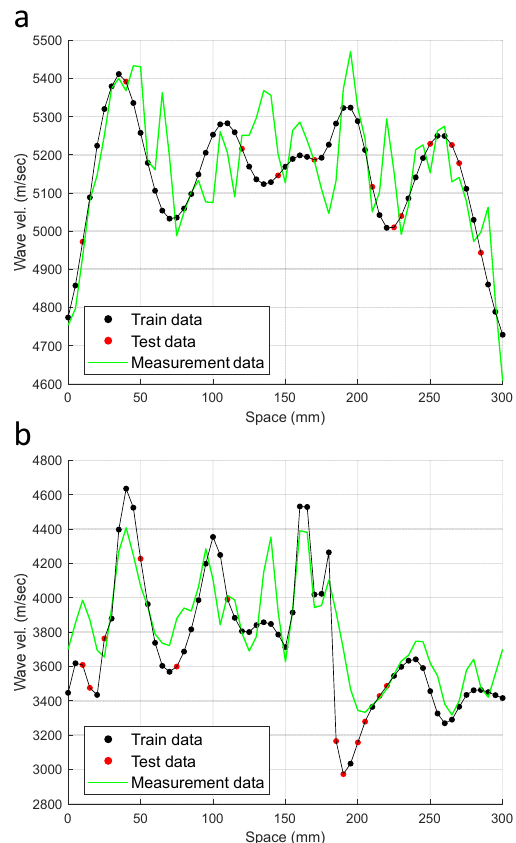
Figure 7. Wave velocity from PINN prediction (black line and points) and measurements (green line): (a) glass sample and (b) mortar